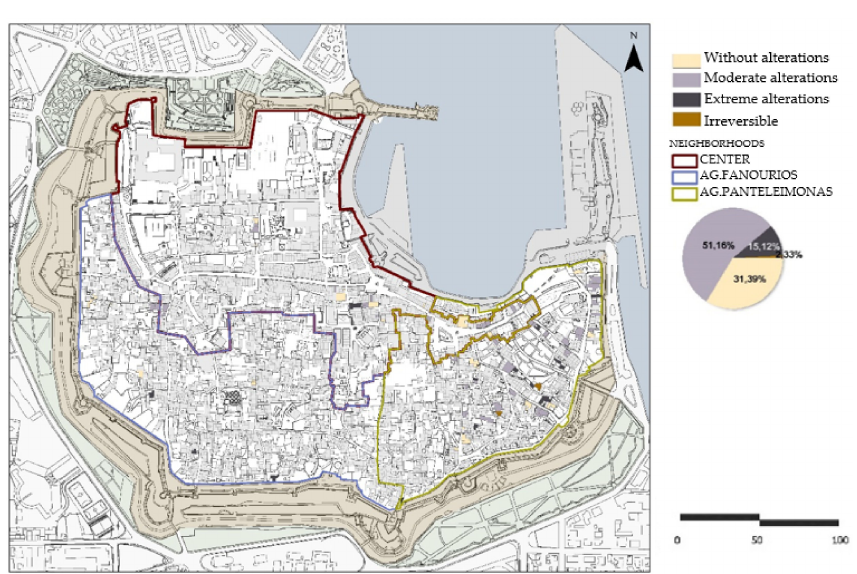
Figure 16. State of morphological